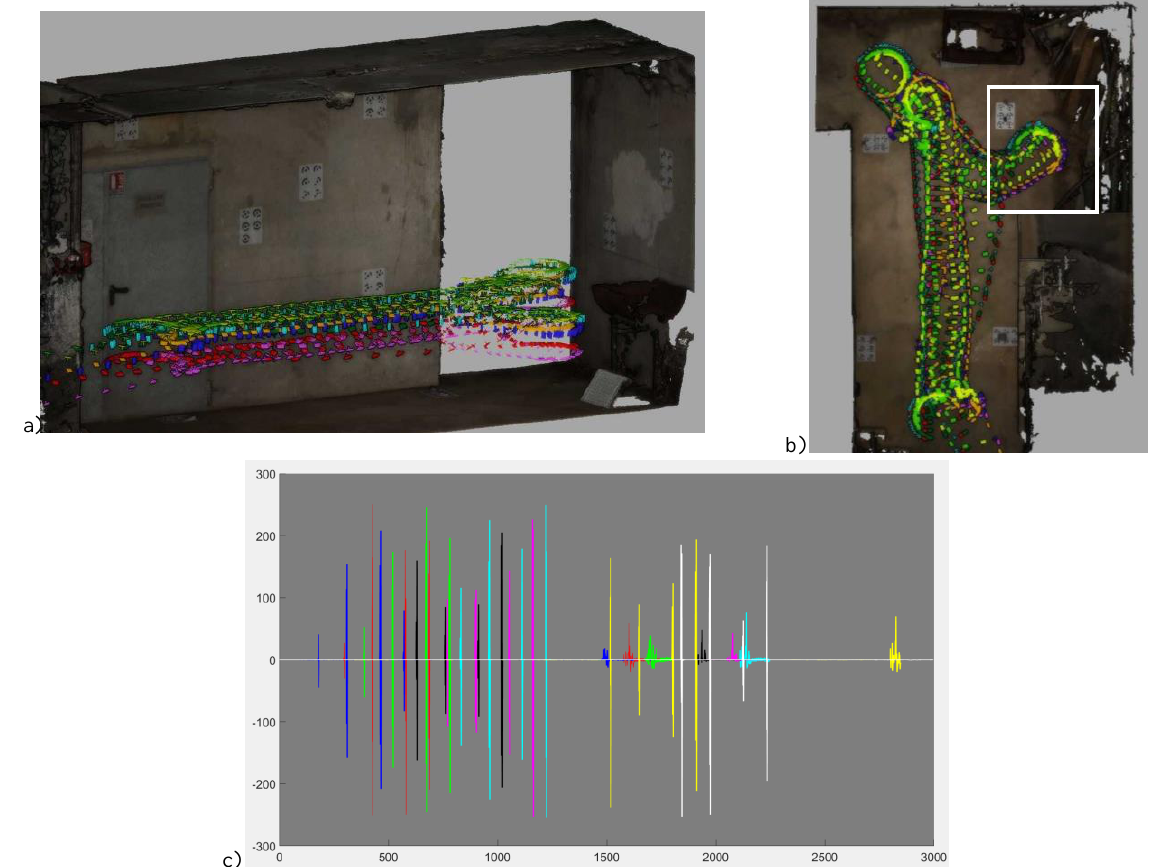
Figure 6. Camera network of the eight GoPro cameras system calibration (a, b). The white rectangle in b indicates the subset selected for the calibration approach 3 in section 5.2. (c) Automatic synchronization method based on the peak values of the median intensity values: four separate events are evident for the eight different cameras, represented by the different colours